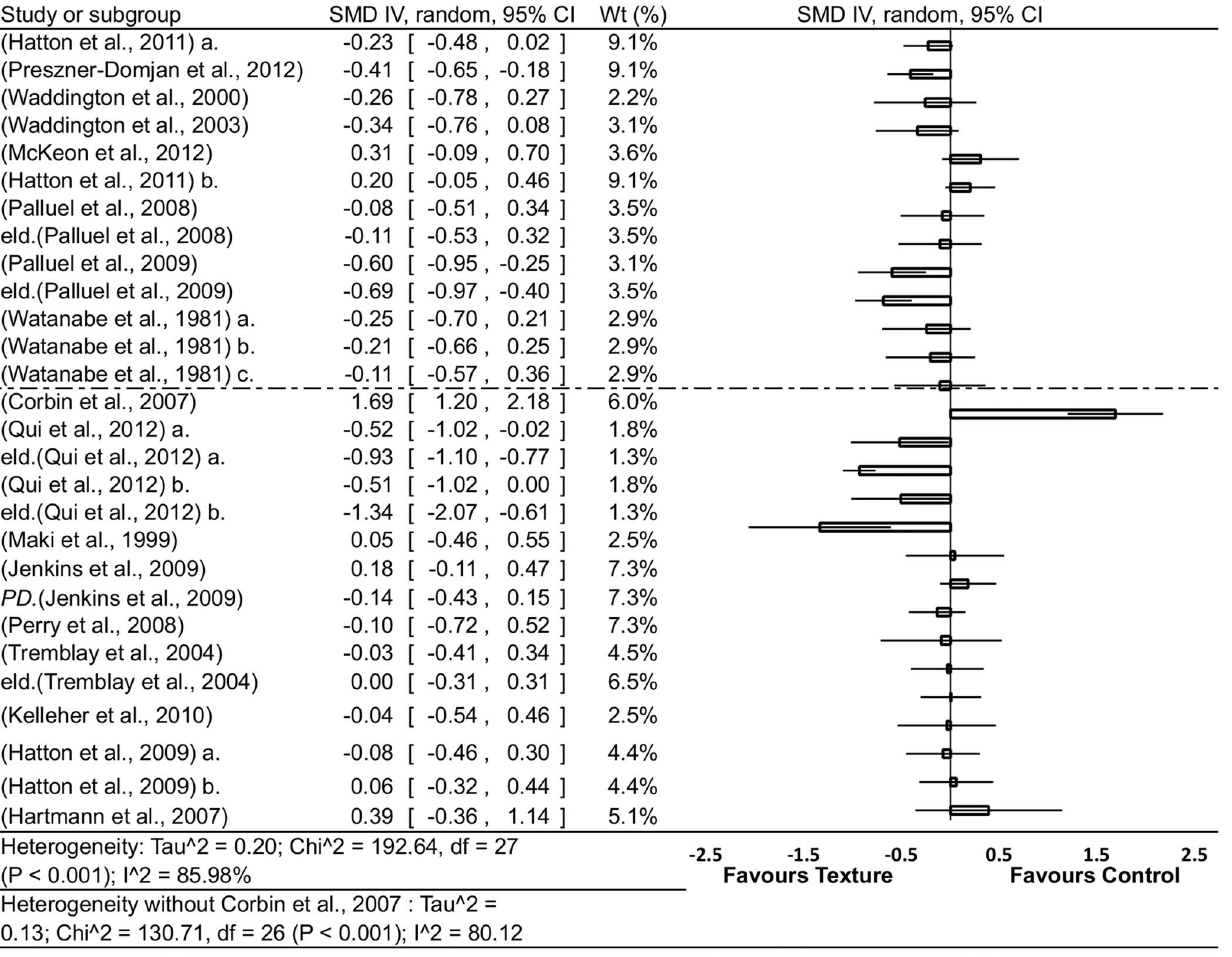
Figure 3. Forrest plot summary of the effect of textured material on perceptual-motor performance. CI =confidence interval; eld. =elderly group; PD =Parkinson’s disease; IV =inverse variance; random =randomized; SMD =standardized mean difference; Wt =weight. Notes: within groups vs baseline and between [8,11] groups vs baseline. The first dashed line from the top includes groups where the internodue distance was known and are in order starting with the smallest to largest internodule disatance. The remaining studies do not report details regarding internodule distance and are in order of how much information was aviliable regarding the texture material characteristics.